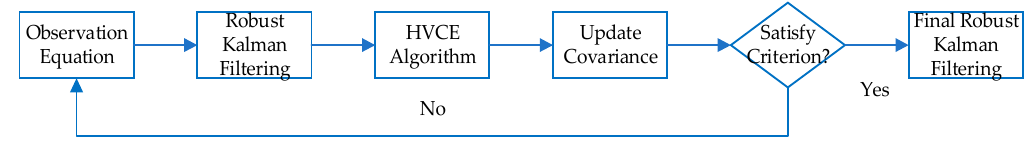
Figure 1. Flow chart of Multi-GNSS HVCE for robust Kalman filtering.